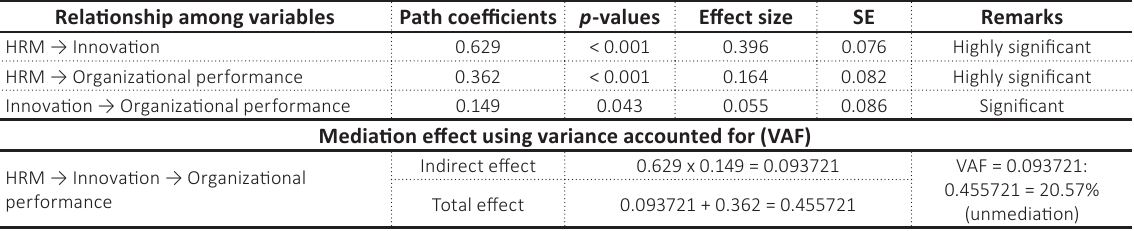
Table 5. Path coefficient direct effect and variance Relationship among